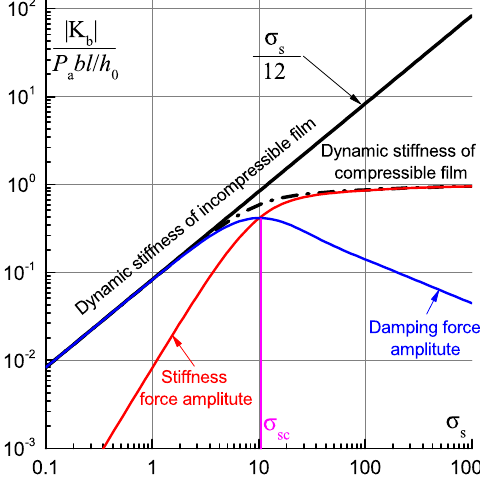
Figure 4. Dynamic coefficients of the 1D parallel slider.